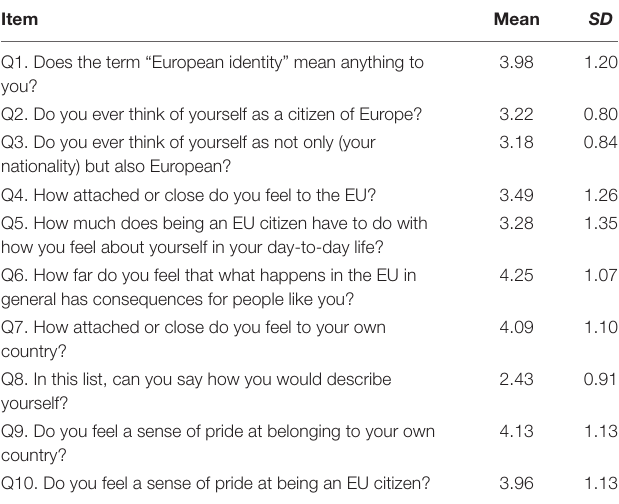
TABLE 2 | Students’ perceptions of European identity before the intervention ( N =